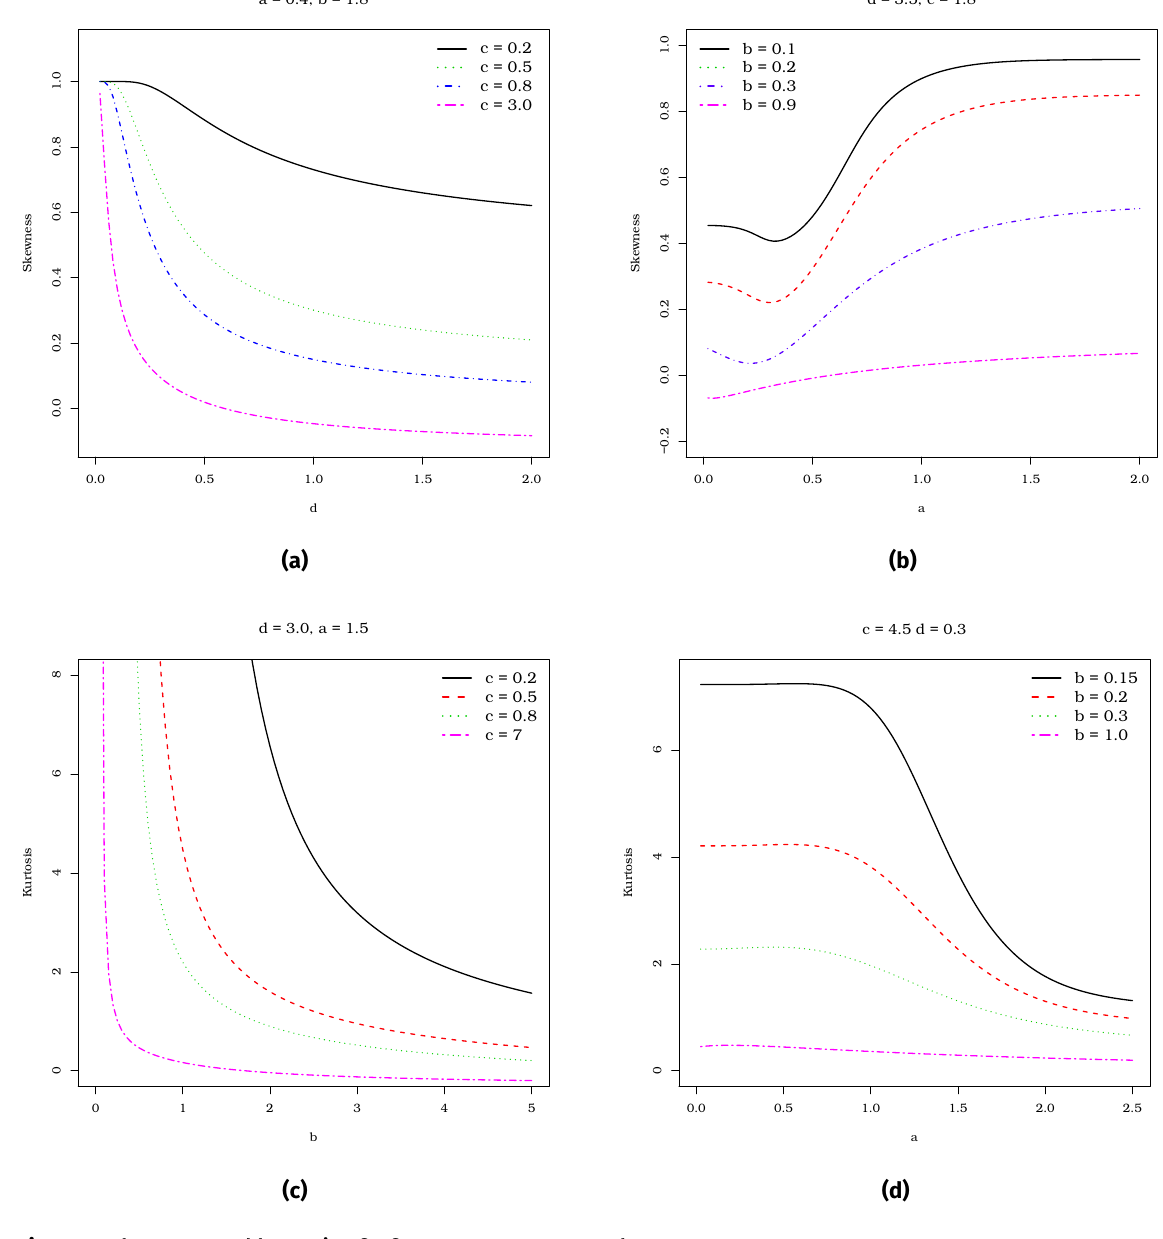
Figure 3. Skewness and kurtosis of X for some parameter